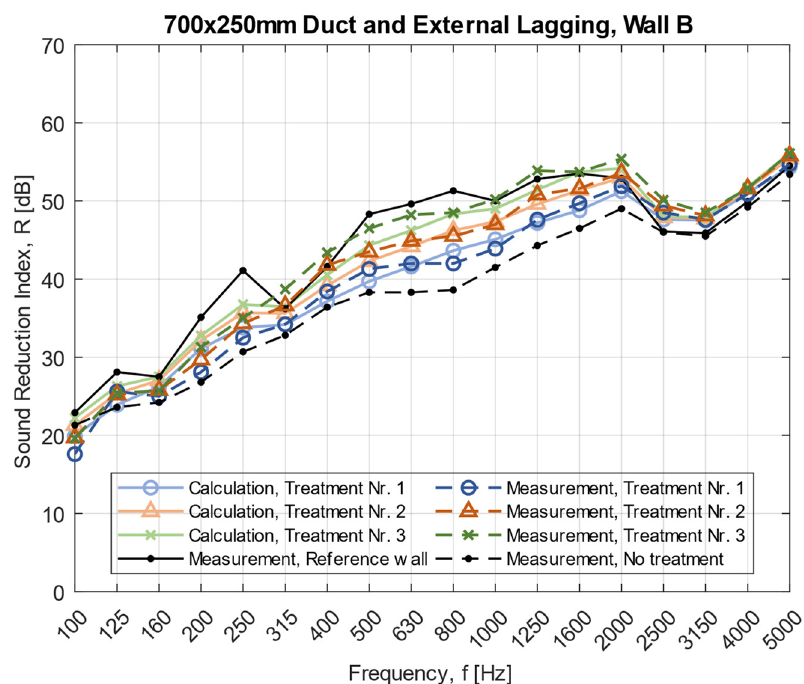
Figure A5. Theoretical models compared to measurements with external lagging as acoustic treatment. Ventilation duct with dimension: 700 × 250 mm through wall B with a sound reduction index of R w = 46 dB. External lagging is mounted at partial lengths of 0.6–1.8 m (Treatment 1–3) with 50 mm stone wool, density of 100 kg/m 3 , closest to the wall.